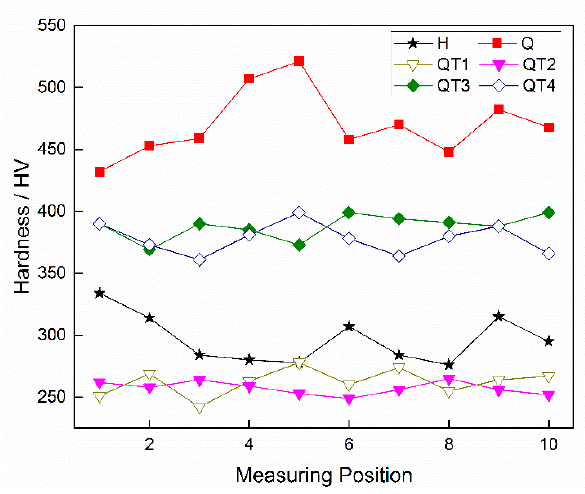
Figure 12. Sample hardness distribution in tube wall radial direction under different heat treatments.